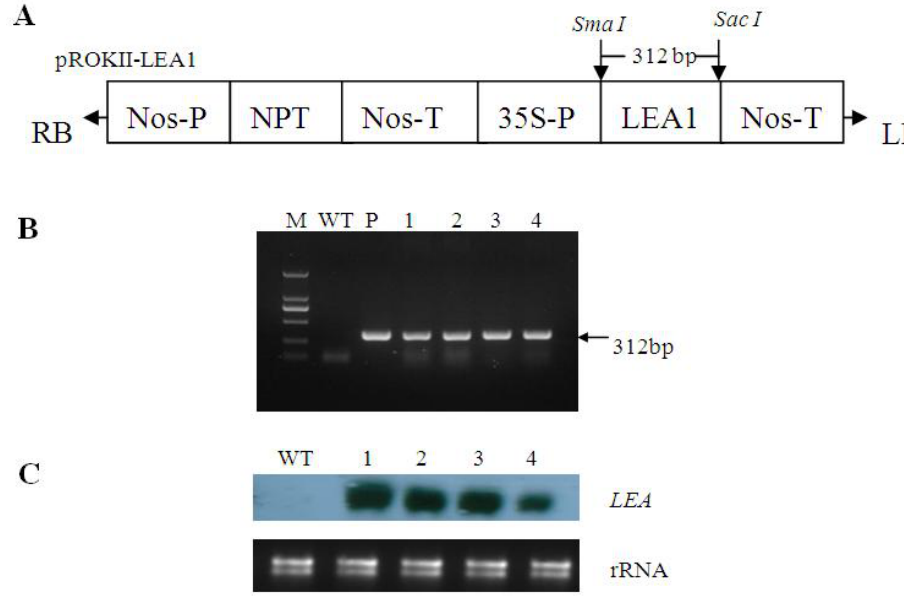
Figure 2. Molecular detection of the TaLEA1 transformed poplar plants ( Populus